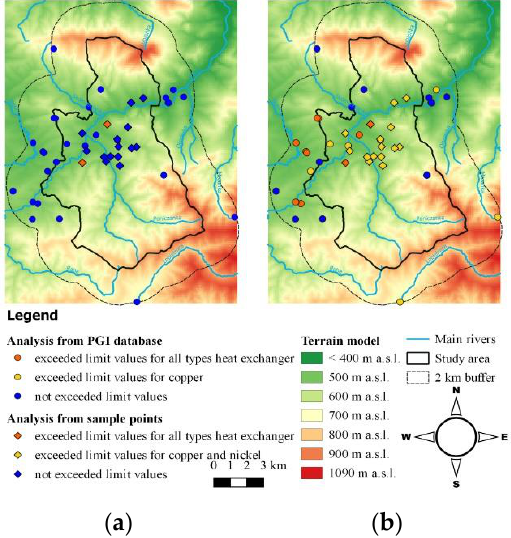
Figure 9. ( a ) Meeting the requirements for one manufacturer; ( b ) Meeting the requirements for all